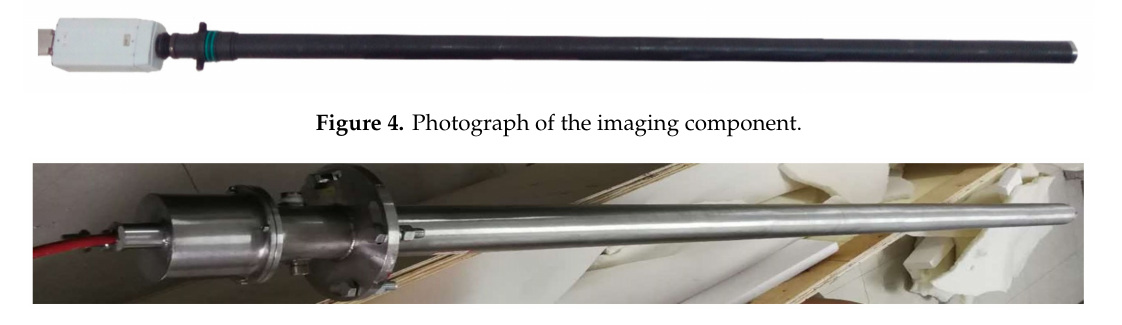
Figure 5. Photograph of the high-temperature industrial endoscope.